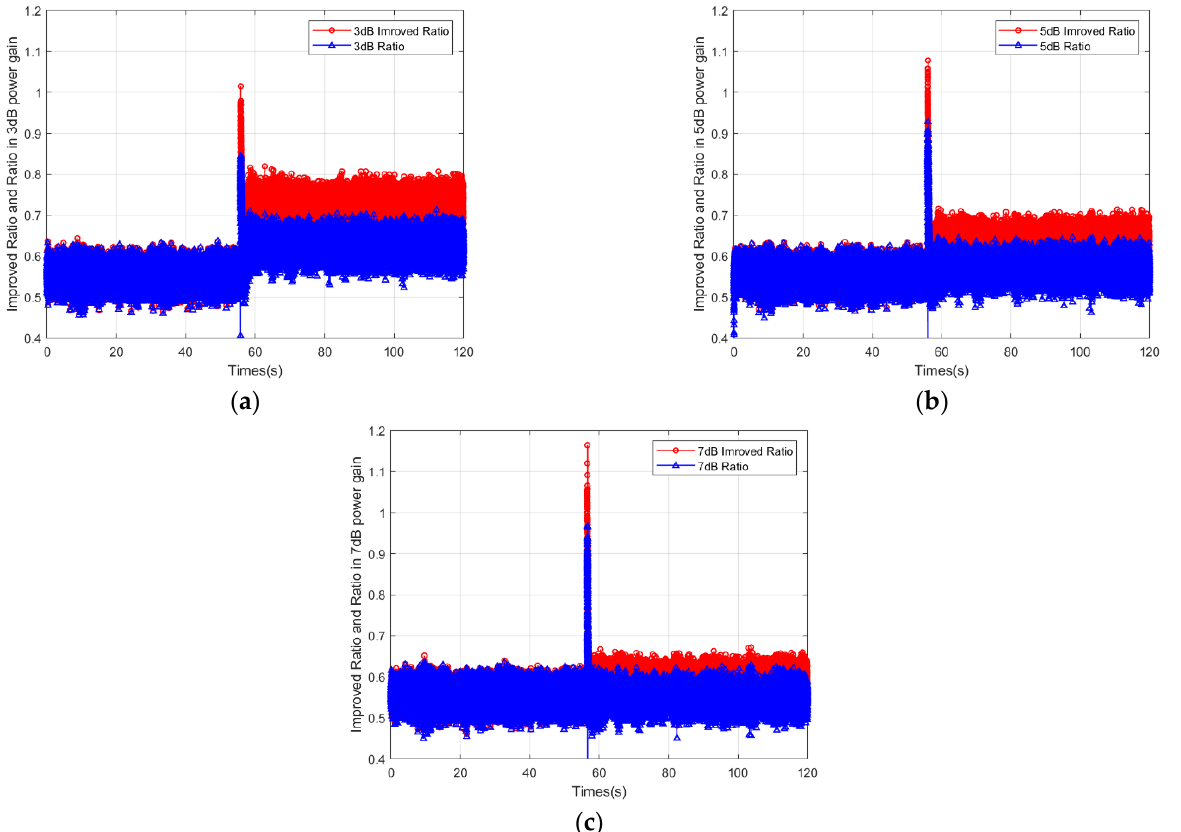
Figure 10. The Improved Ratio and Ratio with Different Spoofing Power Gain: ( a ) The comparison of Improved Ratio and Ratio in 3 dB power gain; ( b ) The comparison of Improved Ratio and Ratio in 5 dB power gain; ( c ) The comparison of Improved Ratio and Ratio in 7 dB power gain.